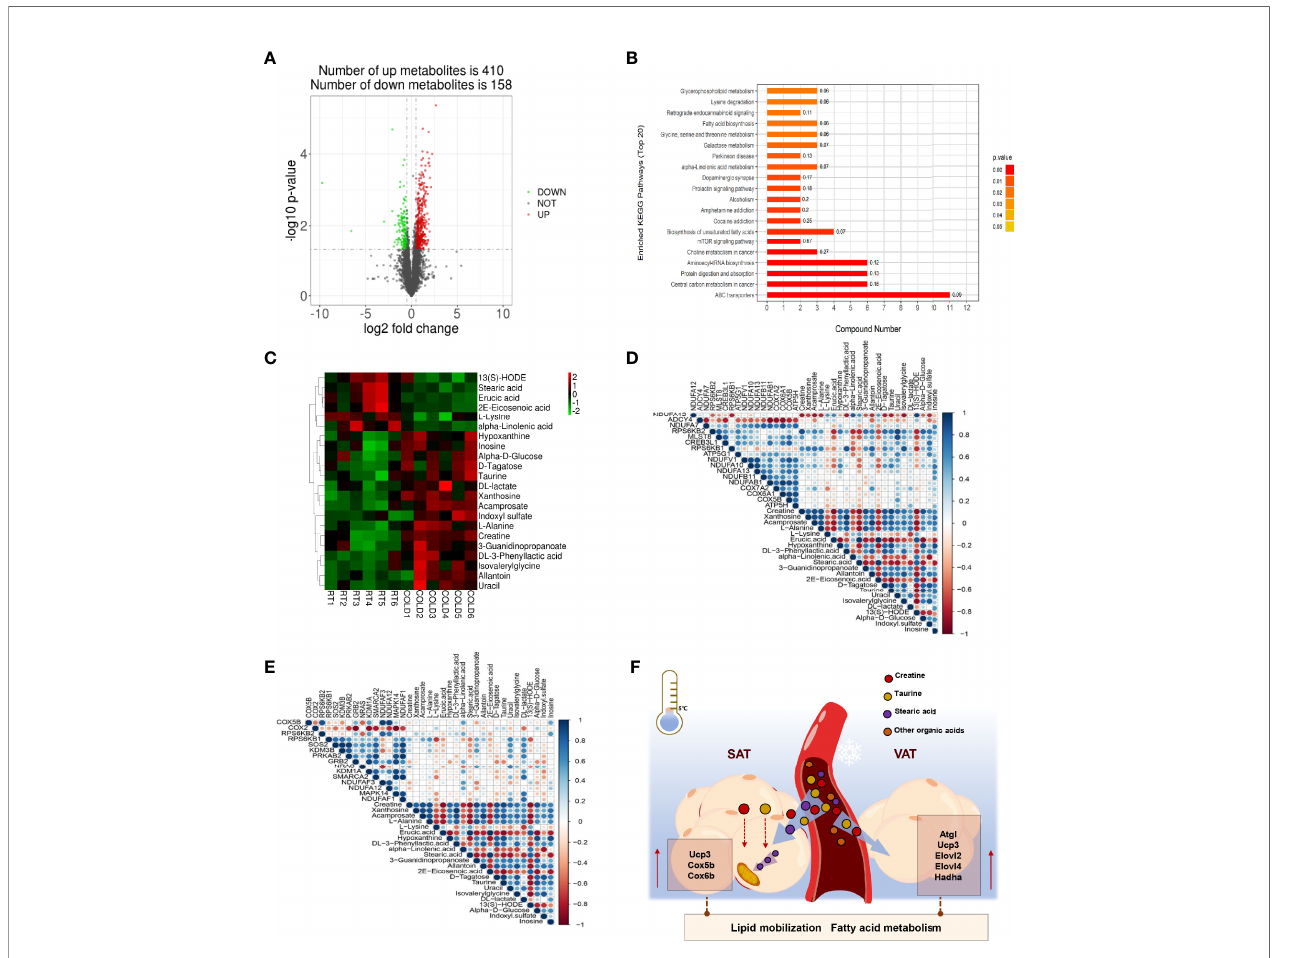
FIGURE 6 | Effect of cold exposure on metabolites of pigs. (A) Volcano plot of pairwise comparisons of all detected negative ions in plasma. The threshold (|log2- fold change|>log2 1.5; P value < 0.05) was de fi ned for each signi fi cantly changed metabolites. Red denotes upregulated metabolites in COLD plasma; green denotes downregulated metabolites in COLD plasma; gray denotes metabolites with no signi fi cant changes. (B) KEGG pathway annotation of top 20 differential metabolites. (C) A heatmap was drawn to show the differential expressed metabolites. Up-regulated expressed metabolites were shown in red; down-regulated expressed metabolites were shown in green. Metabolites were selected from the metabolomics dataset. Only metabolites with P <0.05 were displayed. (D) Heatmap of Pearson correlation coef fi cients between differential expressed metabolites identi fi ed in plasma and thermogenesis relative DEGs in SAT upon cold exposure. Blue denotes positive correlation, Red denotes negative correlation. (E) Heatmap of Pearson correlation coef fi cients between differential expressed metabolites identi fi ed in plasma and thermogenesis relative DEGs in VAT upon cold exposure. Blue denotes positive correlation, red denotes negative correlation. (F) Working model of the metabolic effects between blood and adipose tissues under cold